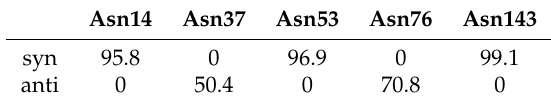
Table 3. Percent of syn/anti conformation for the last 10 ns of the MD simulation.